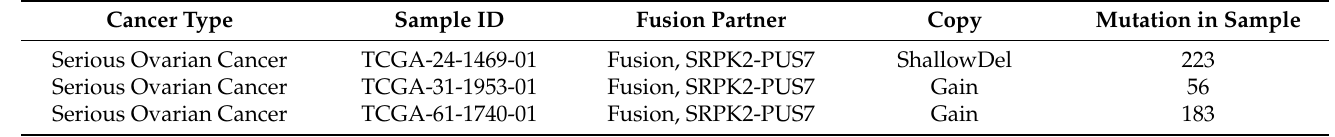
Figure 4. PUS7 protein expression was significantly higher in OV tissues than normal tissues. ( A ) Representative IHC images of PUS7 in normal ( left ) and OV ( right ) tissues in HPA. ( B ) Statistical analysis of the protein expression of PUS7 according to the staining scores of OV and normal tissues. ( C ) Representative IHC images of PUS7 in normal ( left ) and OV ( right ) tissues according to tissue microarray. ( D ) Statistical analysis of the protein expression of PUS7 according to the staining scores of OV and normal tissues. p < 0.05 was considered significant. Table 2. The mutation distribution of PUS7 in ovarian cancer according to